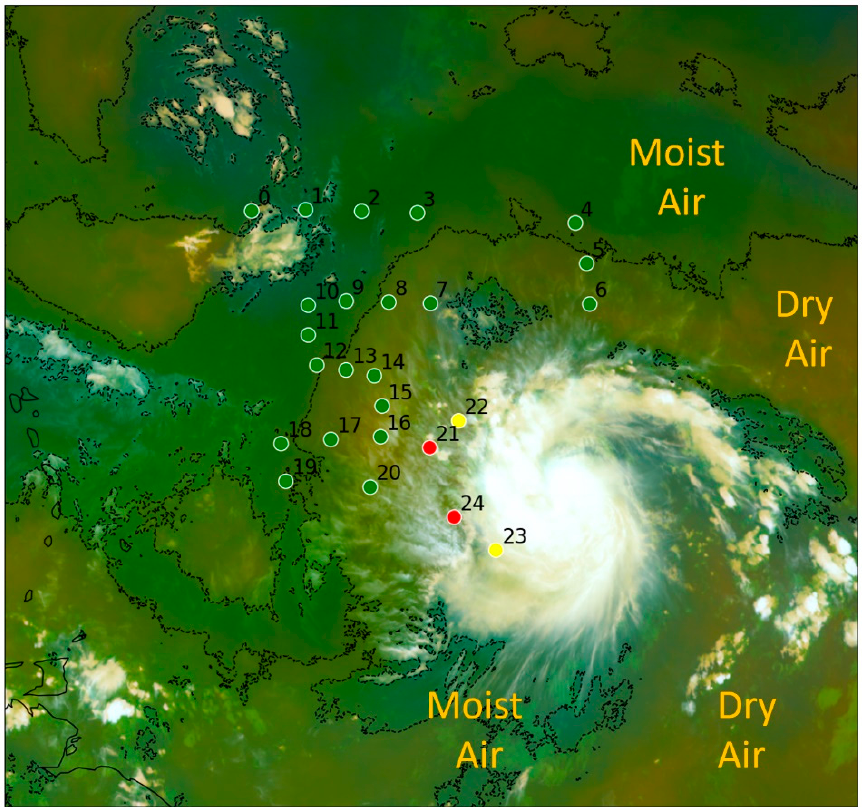
Figure 1. The G-IV flight path on 18 September 2019 between 14:00 and 19:00 UTC showing the dropsonde locations and the quality flag of the nearest match with the NUCAPS retrieval from NOAA-20 satellite. The background shows the GOES-16 Airmass RGB image at 16:00 UTC. The quality flag has three color values, which are green when the IR + MW retrieval passed (clear to partly cloudy scenes), yellow when the MW-only passed (cloudy scenes), and red when both were rejected (precipitating scenes). The dashed contour line is illustrative and drawn from the subtraction of ABI 6.2–7.3 μ m channels.